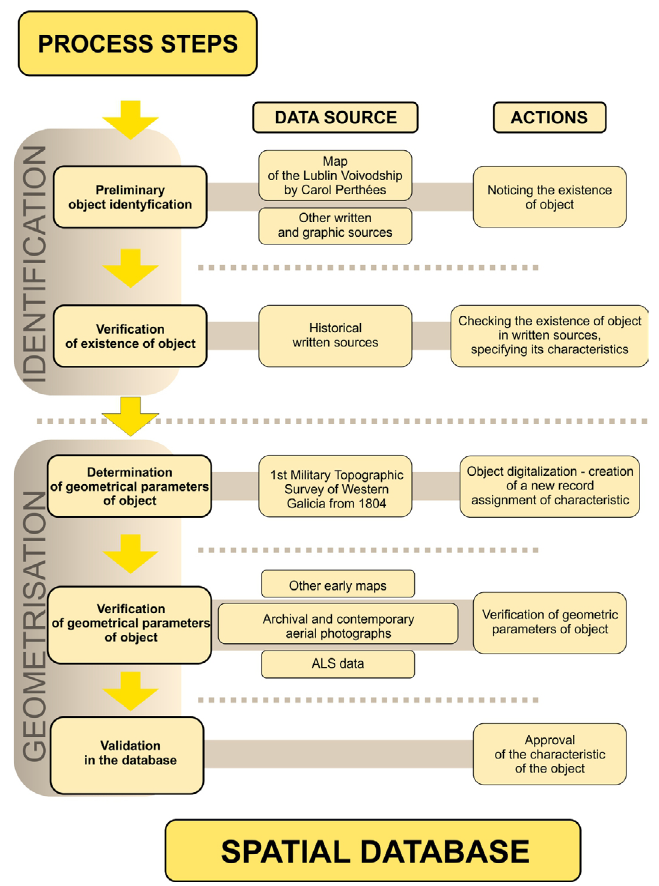
Fig. 4. Diagram of the process of reconstruction of the distribution of elements of the anthropogenic landscape (author’s own work)